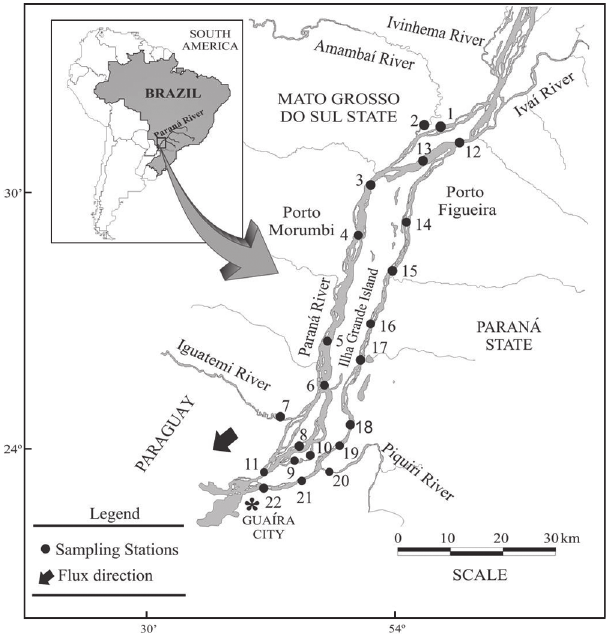
Fig. 1. Location of sampling stations (black dots). (1: Bandeirantes right channel; 2: Amambaí; 3: Triângulo; 4: